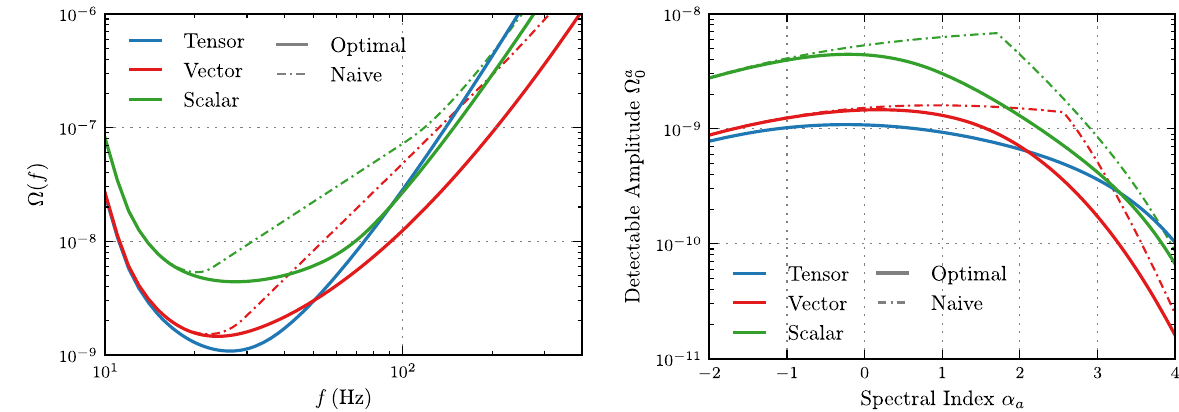
FIG. 3. Left: PI curves showing the sensitivity of Advanced LIGO to stochastic backgrounds of tensor, vector, and scalar polarizations (solid blue, red, and green curves, respectively). Power-law energy-density spectra [Eq. (10)] drawn tangent to the PI curves have expected h SNR i ¼ 3 after 3 years of observation at design sensitivity. Also shown are “ naive ” PI curves for vector and scalar OPT backgrounds (dashed red and green curves) illustrating the sensitivity of existing search methods optimized only for tensor polarizations. Right: Minimum detectable background amplitudes ( h SNR i ¼ 3 after 3 years of observation at design sensitivity) as a function of OPT spectral index α a . For small and negative values of α a , Advanced LIGO is approximately equally sensitive to tensor- and vector- polarized backgrounds. For large α a , Advanced LIGO is instead most sensitive to vector- and scalar-polarized backgrounds. The dashed curves show amplitudes detectable with existing “ naive ” methods. The sensitivity loss between optimal and naive cases is negligible for α ≲ 0 , but becomes significant at moderate positive slopes (e.g., α ∼ 2 ). The kinks in the naive curves are due to biases incurred when a a recovering vector and scalar backgrounds with purely tensor models; see the text for